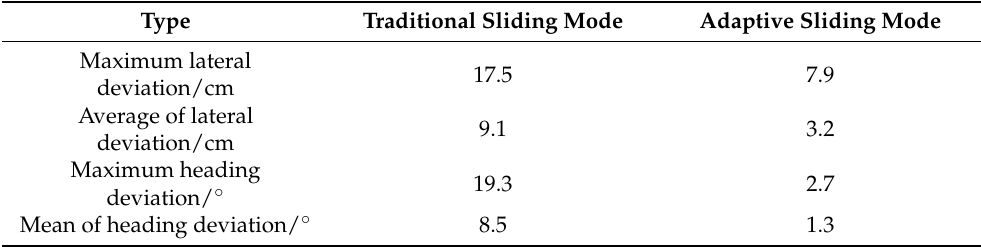
Table 5. Results of